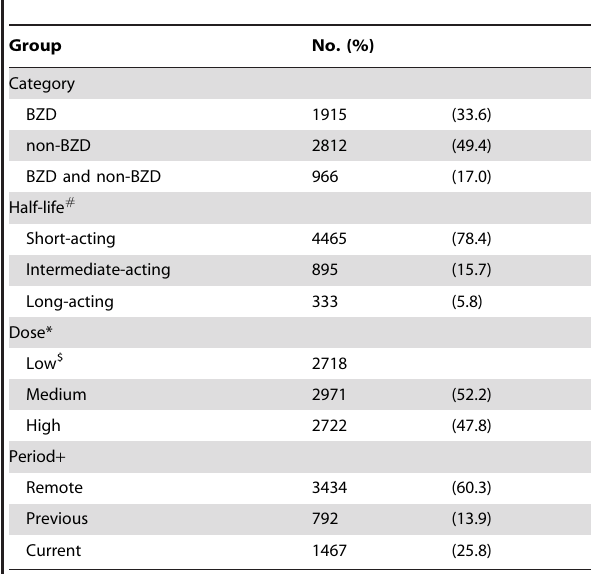
Table 2. Characteristics of subjects with insomnia and hypnotic use (N =5693).